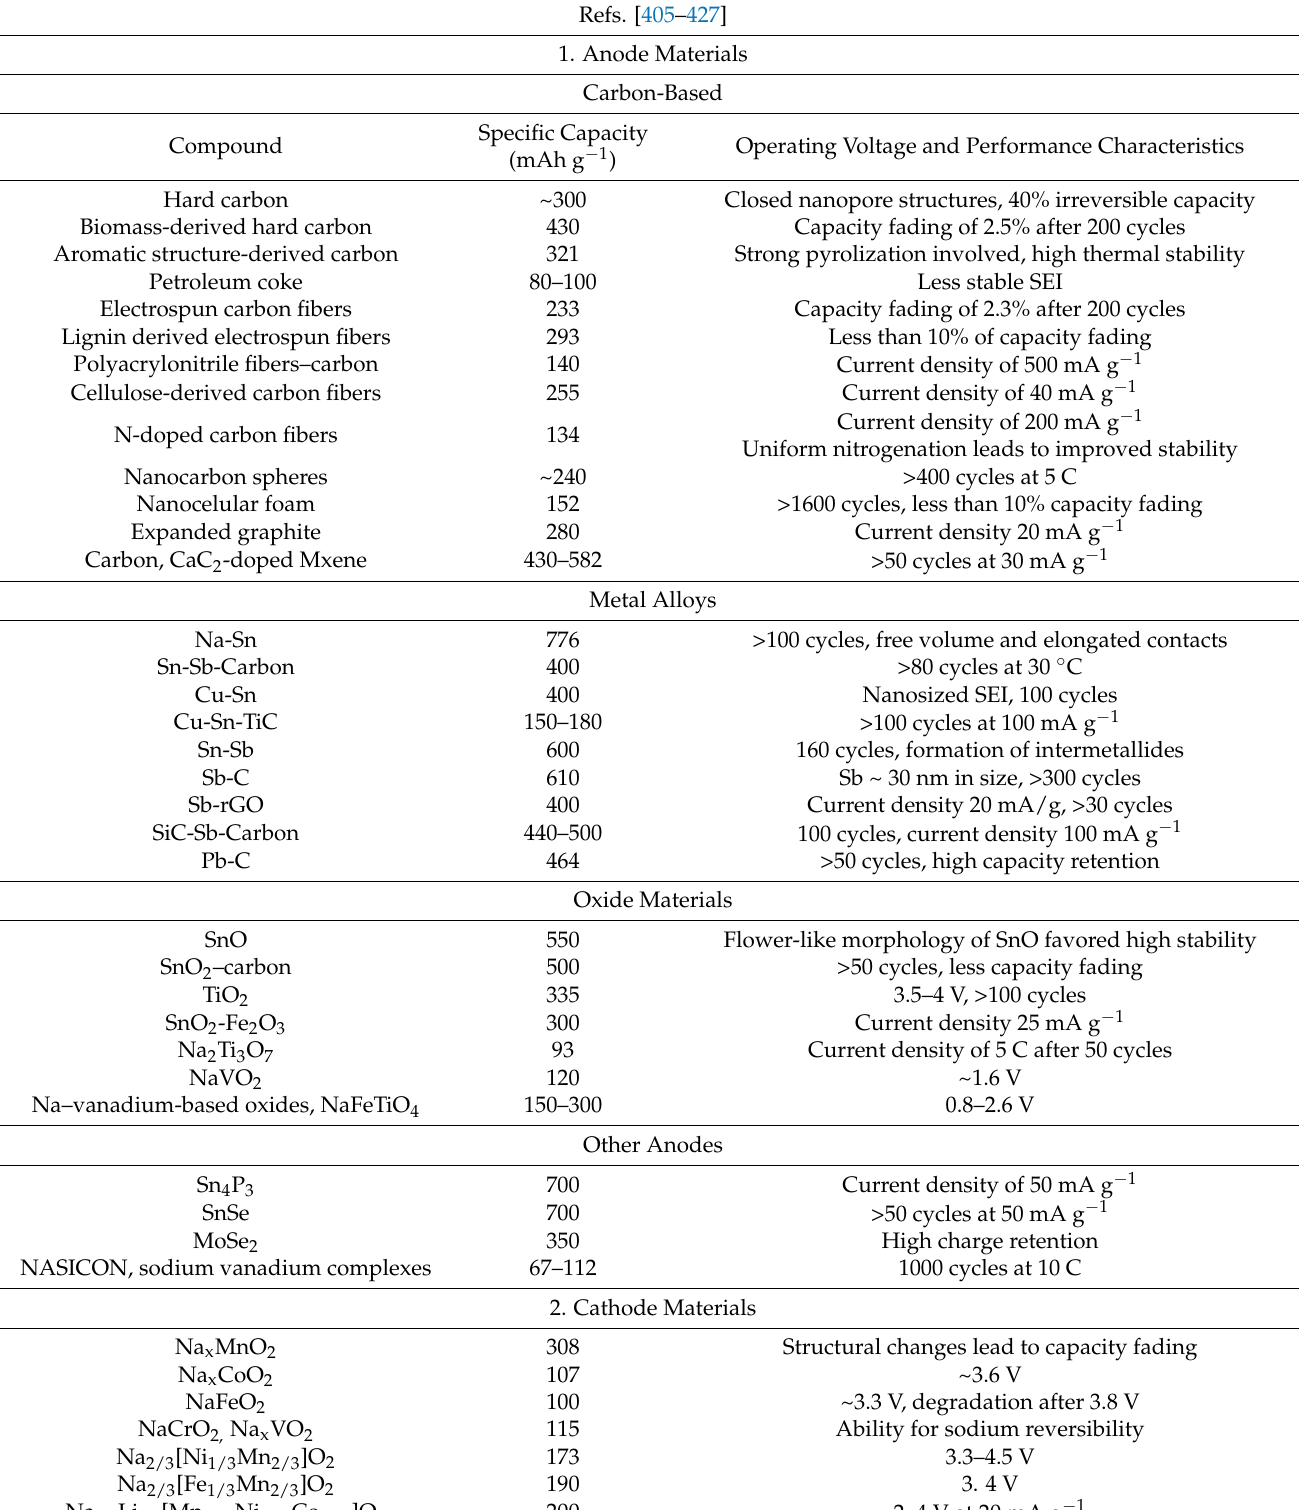
Table 8. Na-ion battery materials and performance